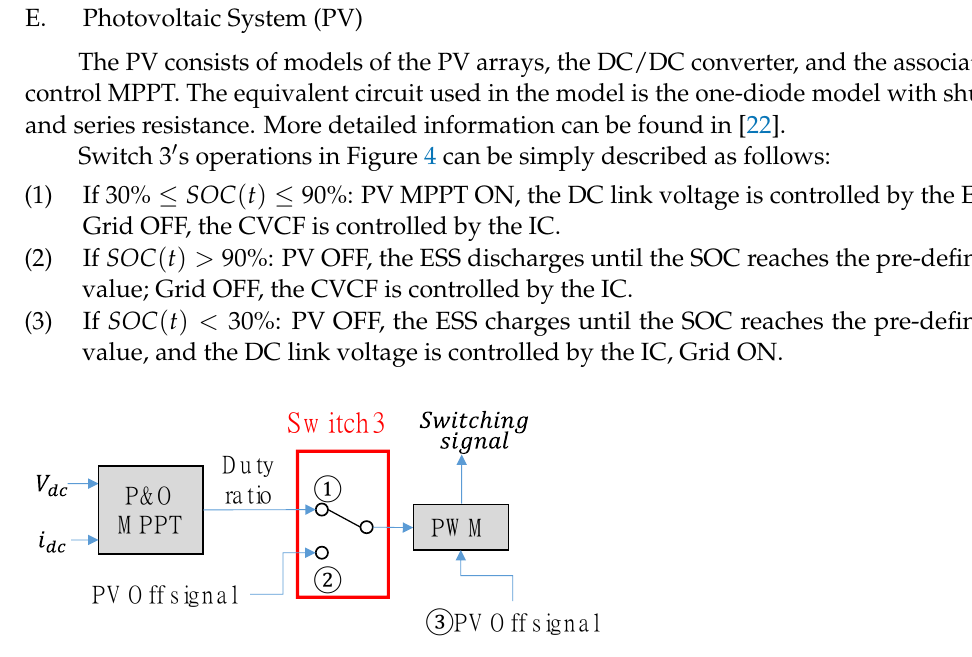
Figure 4. Control block diagram of the boost DC/DC converter of the PV.